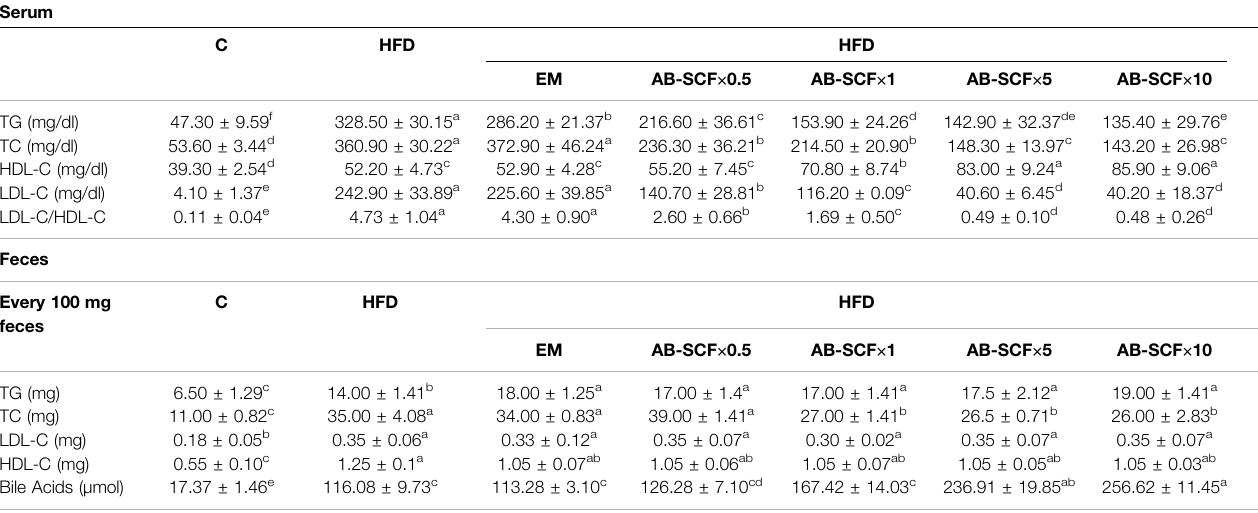
TABLE 2 | Serum and fecal lipid and lipoprotein pro fi les among normal and hyperlipidemic hamsters administrated with AB-SCF.